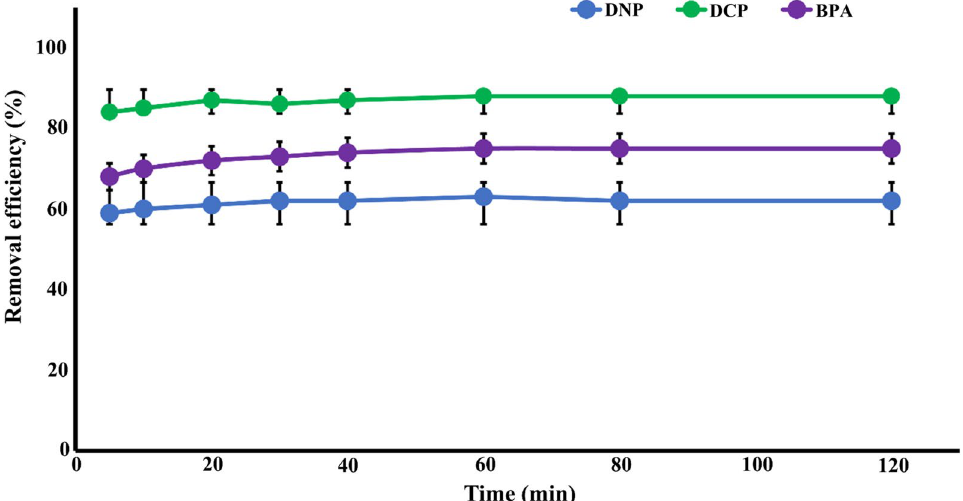
Fig. 7 Effect of contact time on the adsorption efficiency of 2,4-DNP, 2,4-DCP, and BPA. Conditions: (298 K, 10 mL of 10 mg L − 1 of analyte solution at pH 2, 7, and 6, 20 mg sorbent dose, at 250 rpm shaking